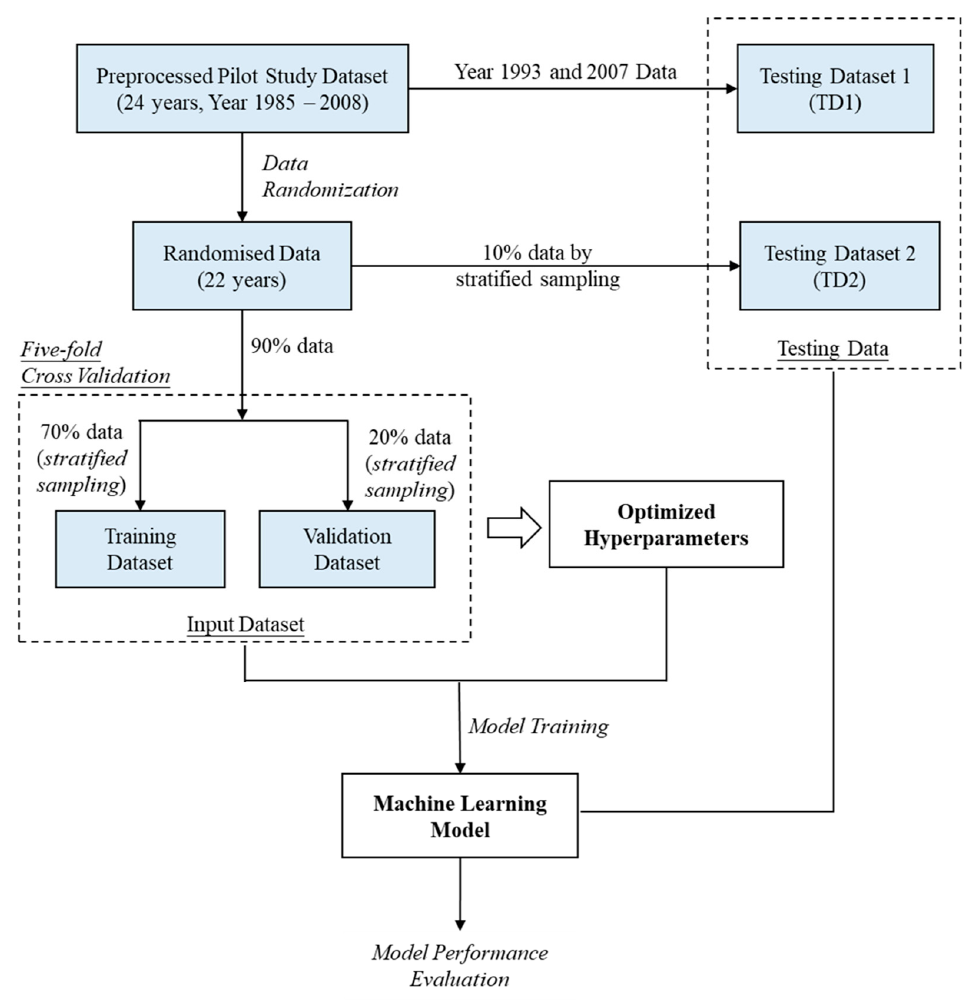
Figure 8. Resampling of Data in the Pilot Study.